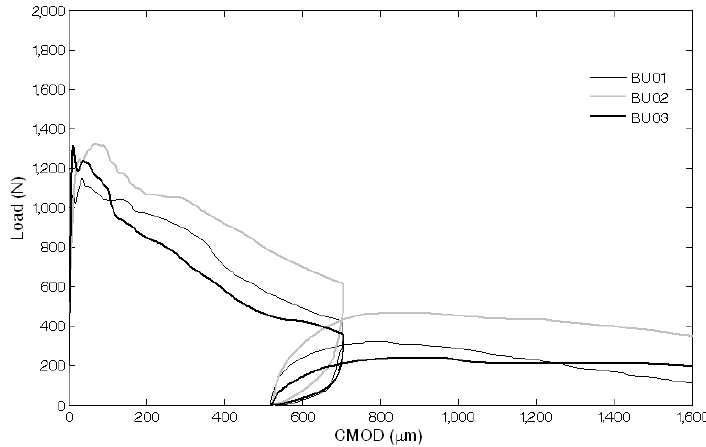
Figure 12. Load vs . CMOD curves for self-healing specimens with bucatini (BU series) resulting from pre-loading and re-loading stages.